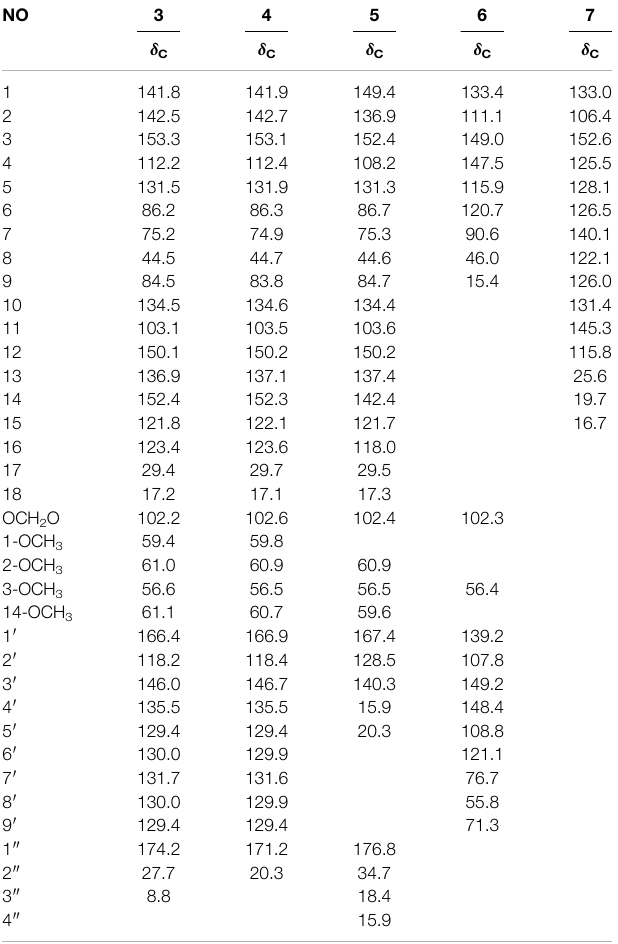
TABLE 3 | ｜ 13 C NMR (150 MHz) data of compounds 3 – 6 in CD 3 OD and 7 in